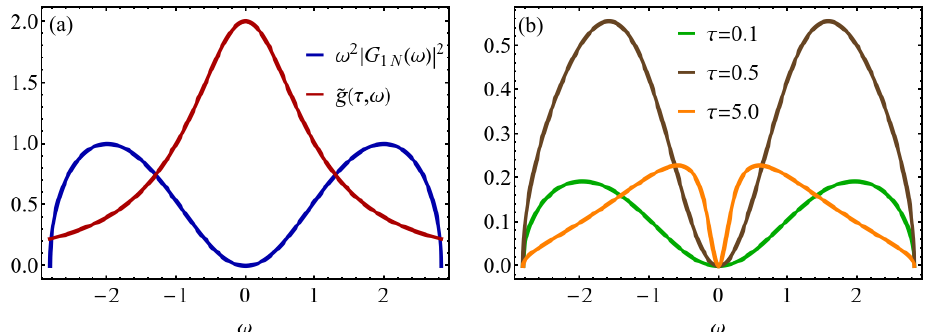
( ω ) | 2 in the N → ∞ 1 N